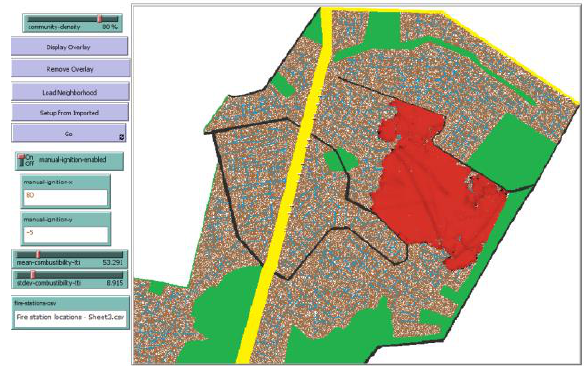
Figure 5 . Simulation with the same variables at 80% density, reaching General Alarm level.